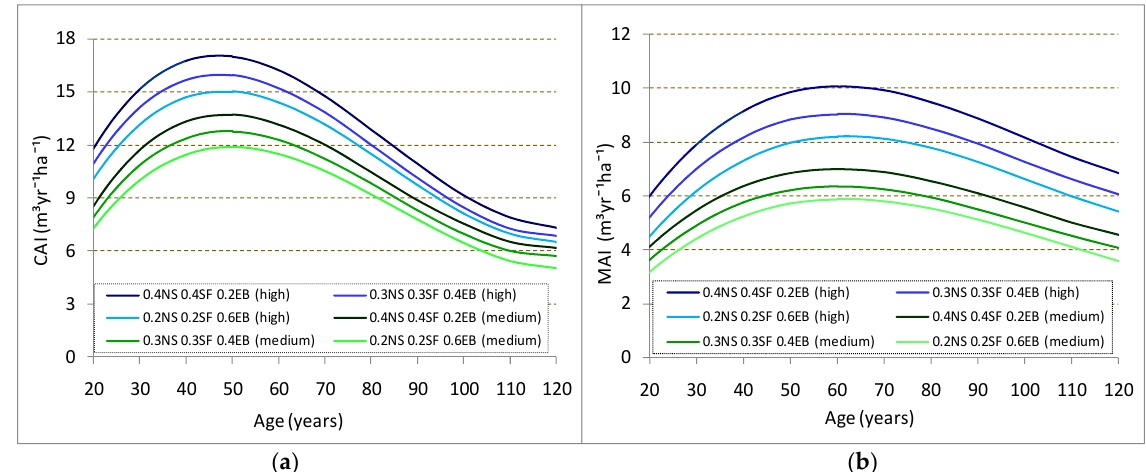
Figure 8. Current annual volume increment ( CAI ) ( a ) and mean annual volume increment ( MAI ) ( b ) for mixed stand with